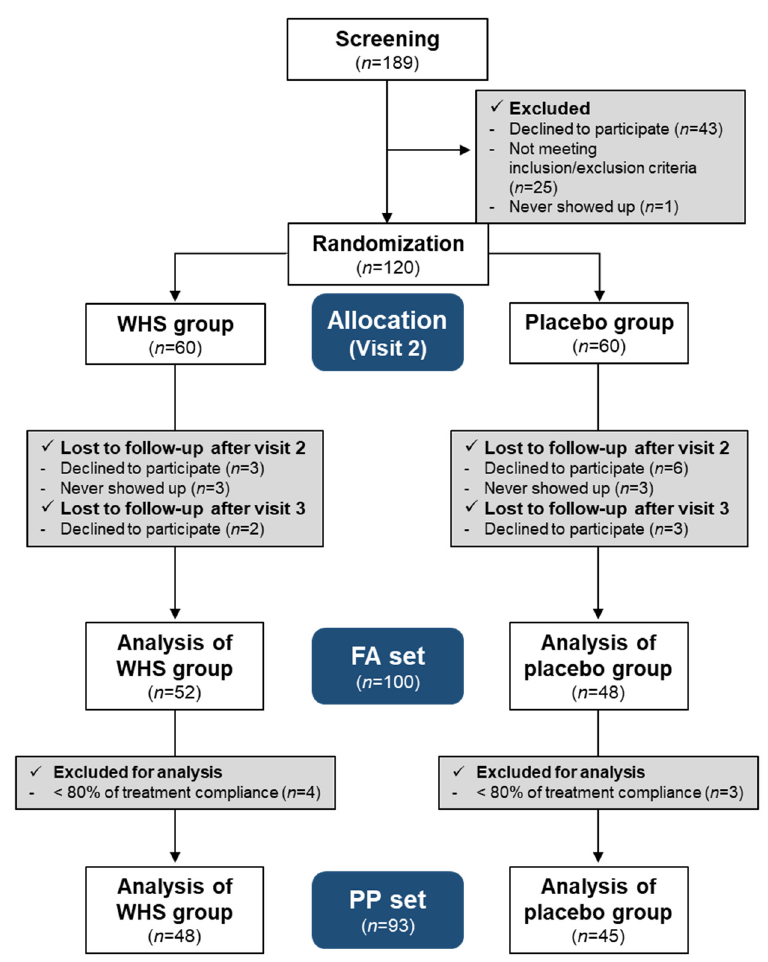
Figure 2. Flow diagram of the enrolled participants. Table 1. Baseline demographic characteristics of the subjects.